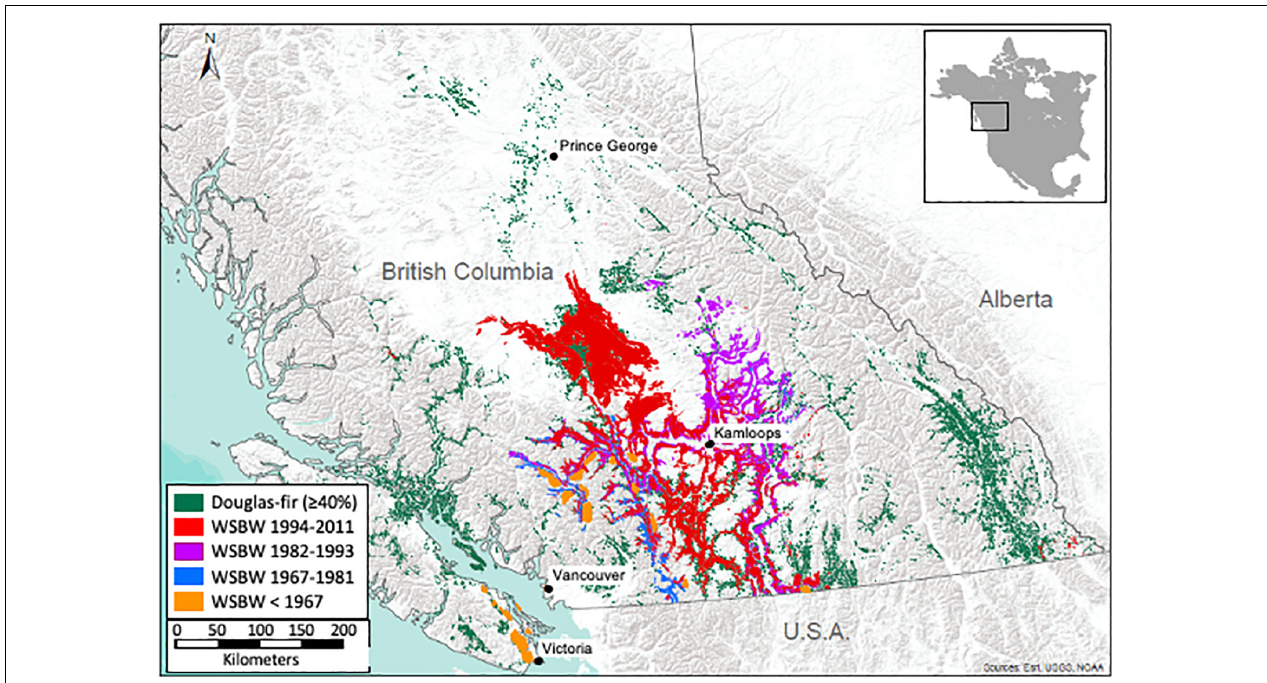
FIGURE 1 | Distribution of western spruce budworm (WSBW) outbreaks from 1909 to 2011 in relation to its primary host, Douglas-fir, in British Columbia, Canada. Only polygons comprising ≥ 40% Douglas-fir are depicted. Western spruce budworm infestations are grouped into four periods to facilitate visualization of range shifts over time. The location of infestations was determined by ground observations from 1909 to 1960 and from aerial surveys thereafter. Data were provided by the BC Ministry of Forests, Lands, Natural Resource Operations and Rural Development.